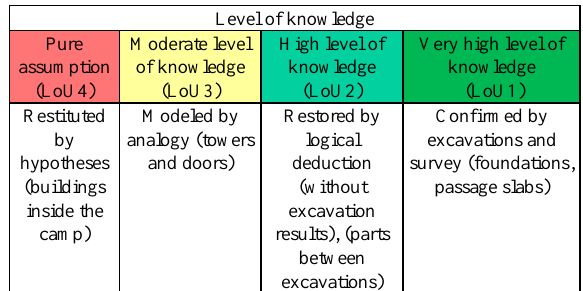
Table 2. Description of the level of uncertainty which might be associated to the 3D model of the Castellum .